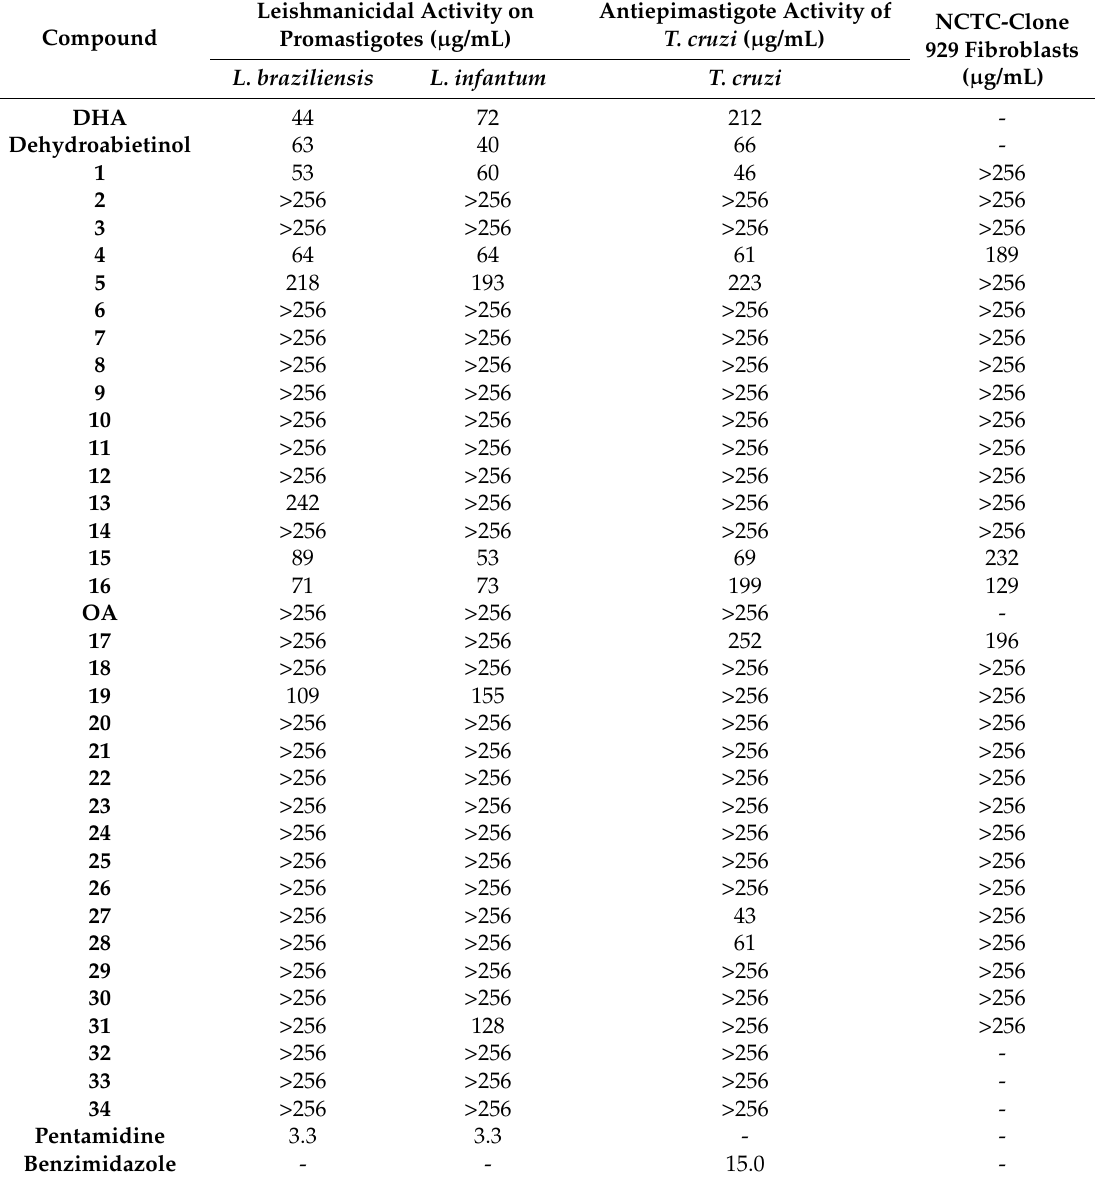
Table 1. Antiprotozoal activity of the starting terpenes dehydroabietic acid (DHA), oleanolic acid (OA), and synthetic derivatives 1 – 34 towards Leishmania promastigotes, Trypanosoma cruzi epimastigotes, and cytotoxicity on NCTC-Clone 929 cells. The results are presented as IC 50 data in ( µ